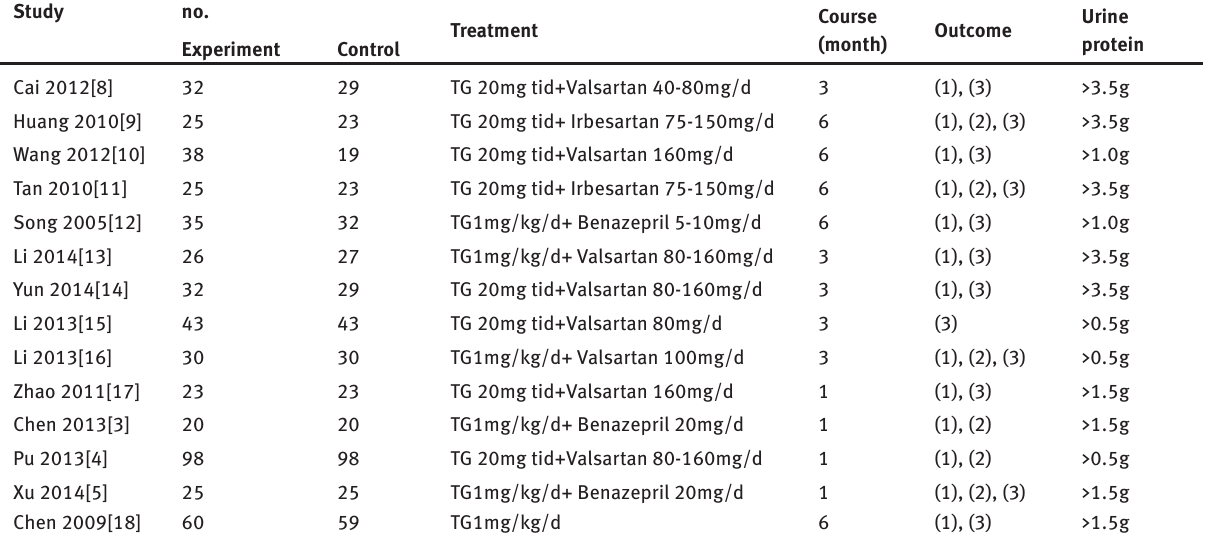
Table 1: Main characteristics of the 14 studies Study no.